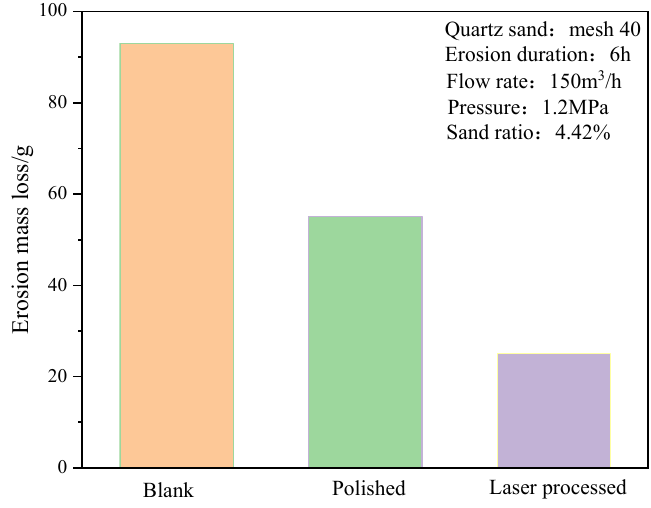
Figure 13. Erosion mass loss of different pretreatment valve cores.